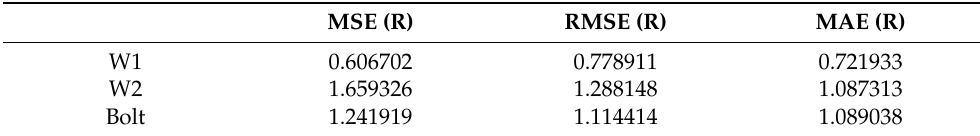
Table 6. Rotation accuracy of real objects in railway transportation.